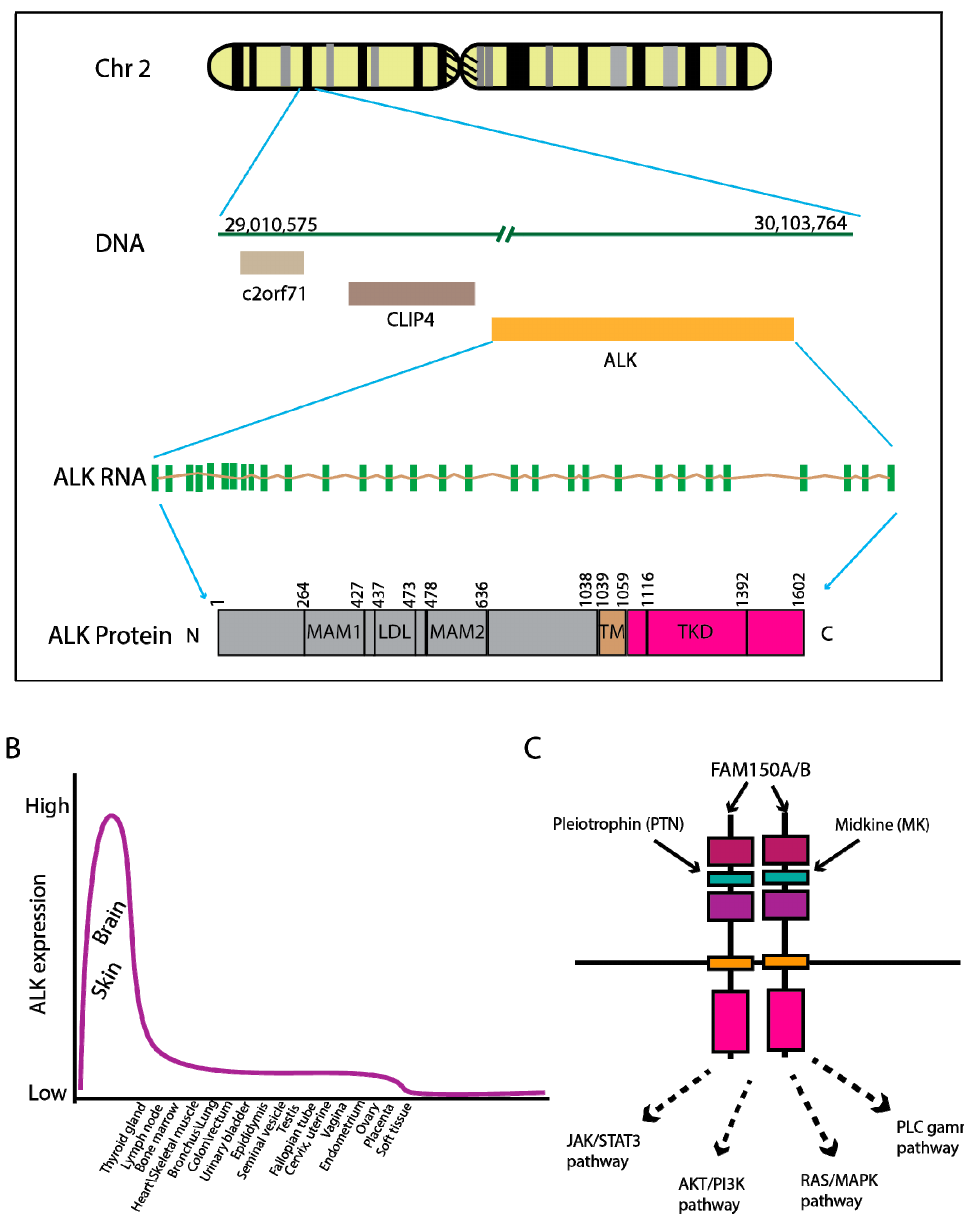
Figure 1. Genomic location and expression of ALK in physiological condition. ( A ) The human ALK gene is located on Chr2 p23.2–23.1 and expresses an RNA transcript of approximately 6267 kb encompassing 29 exons. The encoded protein contains 1602 amino acids with extracellular domains of two meprin, A-5 protein, multiple receptor protein-tyrosine phosphatase mu (MAM) regions and a low-density lipoprotein receptor domain class A (LDLa), a transmembrane domain (TM) and intracellular kinase domain (TKD). ( B ) The distribution of normal ALK protein expression in a variety of tissues/organs. adopted from the human protein atlas [2]. ( C ) ALK is a receptor tyrosine kinase. It is activated by ligand-binding and subsequent phosphorylation, transduces signaling through well-characterized JAK/STAT3, PI3K/AKT, RAS/MAPK, and PLC-gamma pathways. Three known ligands are: pleiotrophin (PTN), Midkin (MK) and FAM150A/B. The ALK gene has been found to be rearranged, mutated, or amplified in a series of tumors including anaplastic large cell lymphomas (ALCL), neuroblastoma, and non-small cell lung cancer (NSCLC) [9]. Chromosomal rearrangements are the most common alterations in this gene and result in creation of genetic fusions such as EML4 (chromosome 2)- ALK (chromosome 2) [10], RANBP2 (chromosome 2)- ALK , ATIC (chromosome 2)- ALK , TFG (chromosome 3)- ALK , NPM1